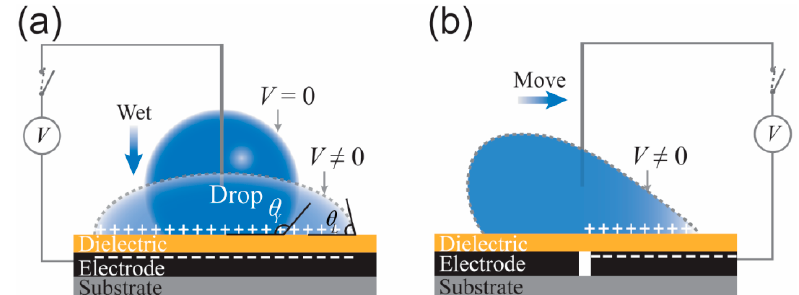
Figure 15. Schematic illustrations of the activation of a fluid droplet on a DMF chip by using the electrowetting on dielectric (EWOD) technique and of droplet wetting when a certain voltage is applied to the system: ( a ) symmetric and ( b ) asymmetric.